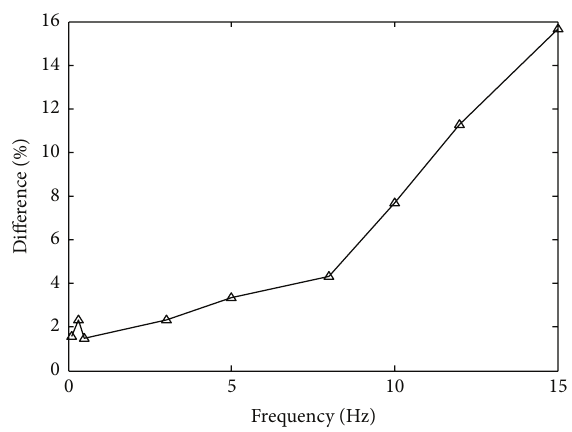
Figure 5: Difference between theoretical model and experiment.